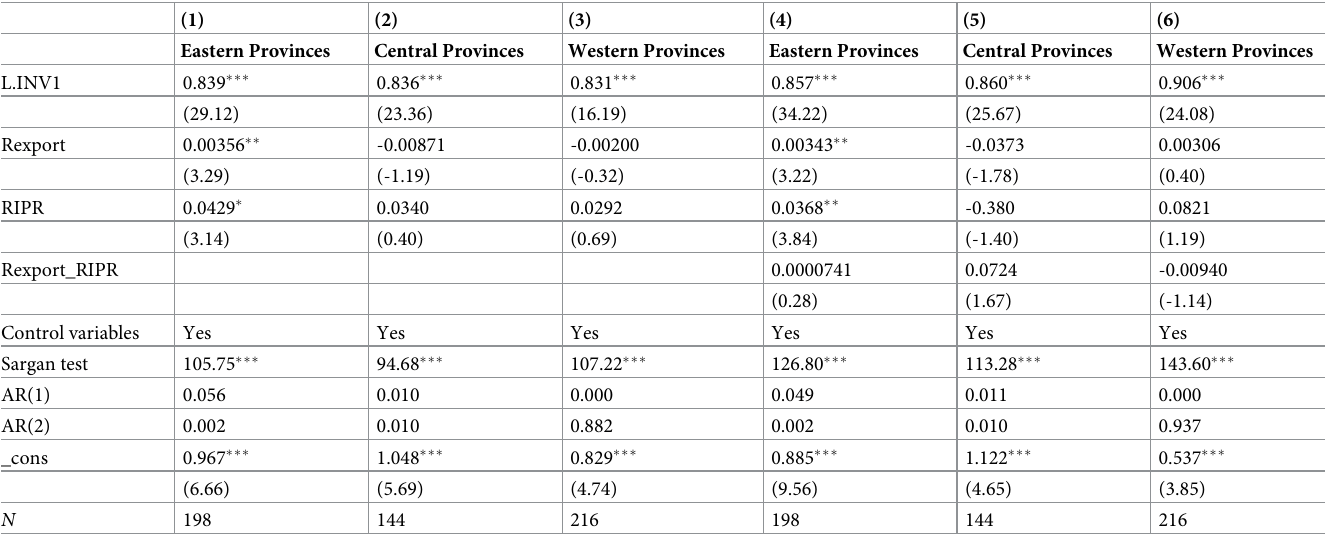
Table 8. System GMM estimates by region ( Rexport